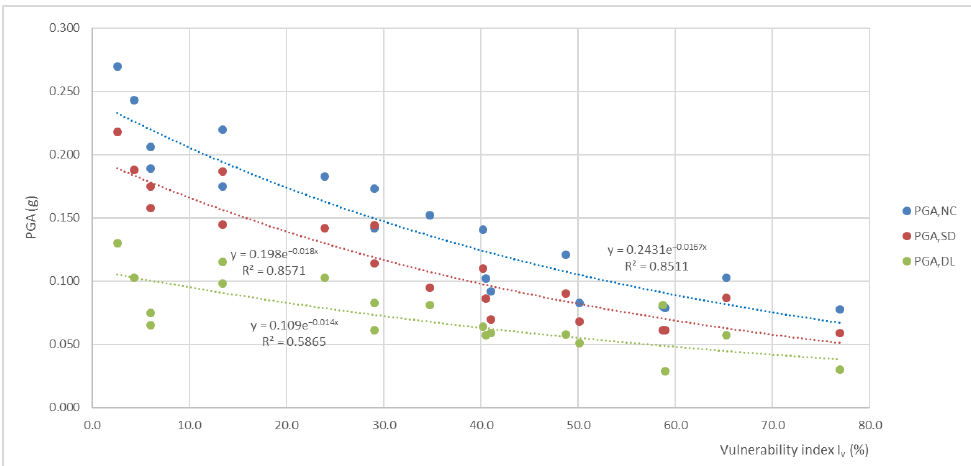
Figure 14. Trend lines I v – PGA DL , I v – PGA SD , and I v – PGA NC